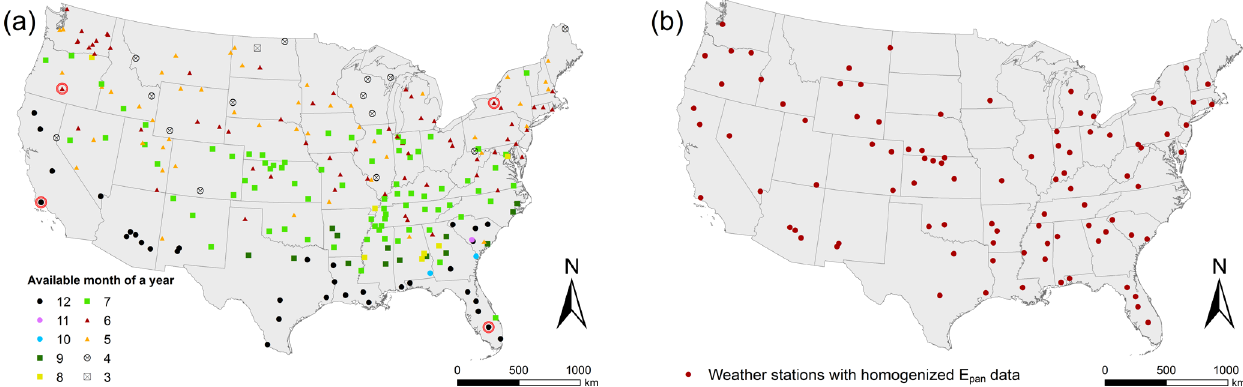
Figure 3. (a) Map of 259 weather stations. The available month of a year of pan evaporation data for each weather station is presented using legends with different colors and shapes. Four representative weather stations are selected from the four quadrants of the US, respectively, which are highlighted with red circles. (b) Map of 93 weather stations with homogenized pan evaporation data that overlap the 259-station